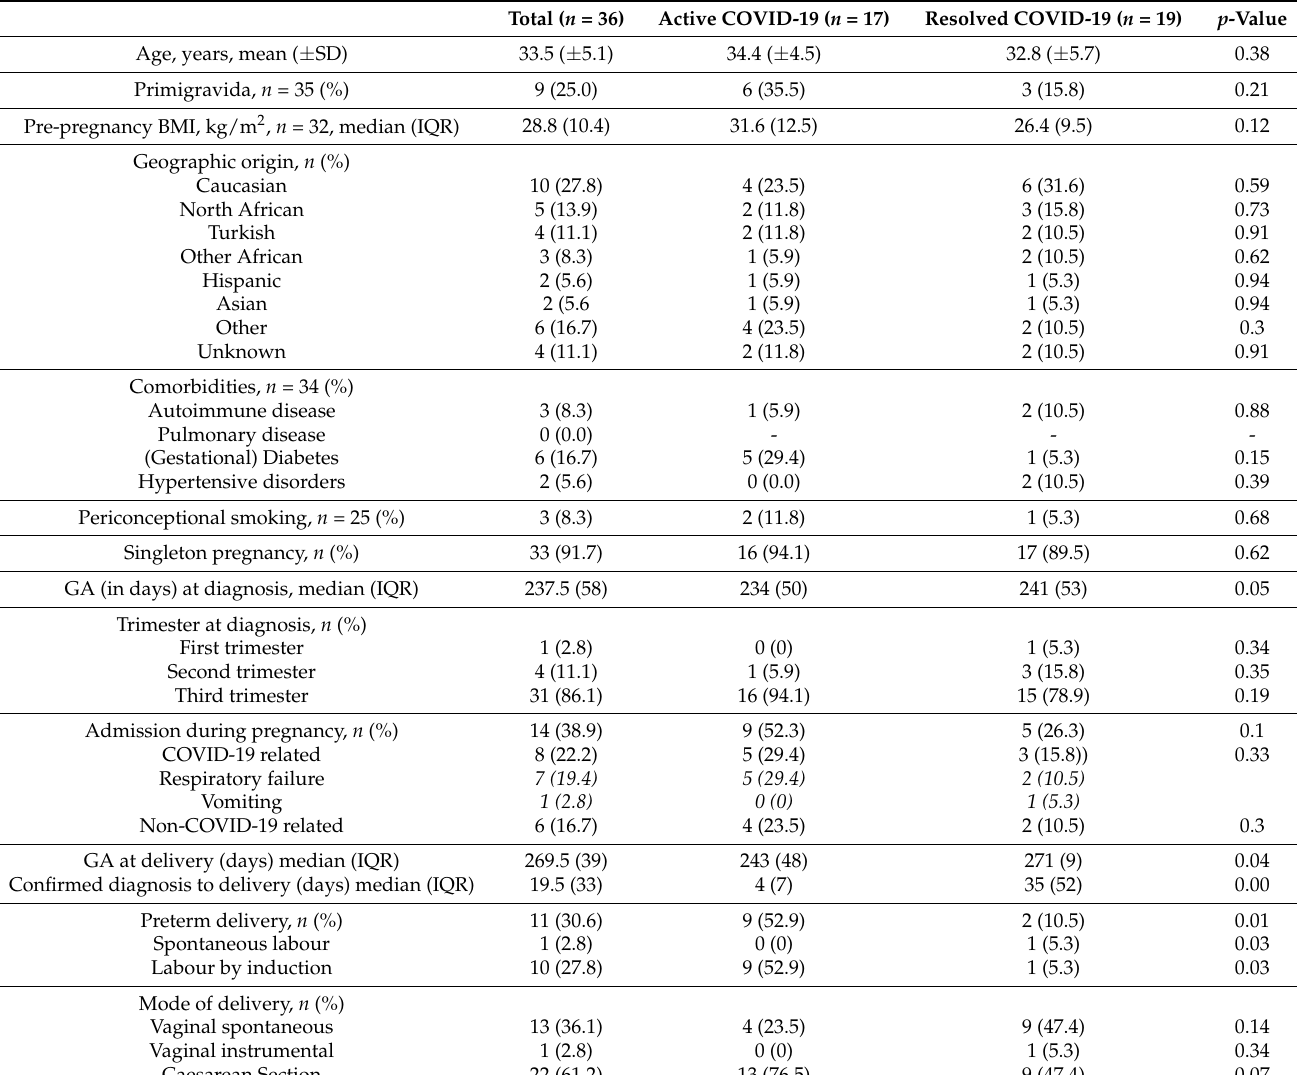
Table 1. General maternal characteristics and obstetric outcomes for the total study population and subgroups active COVID-19 and resolved COVID-19 at time of giving